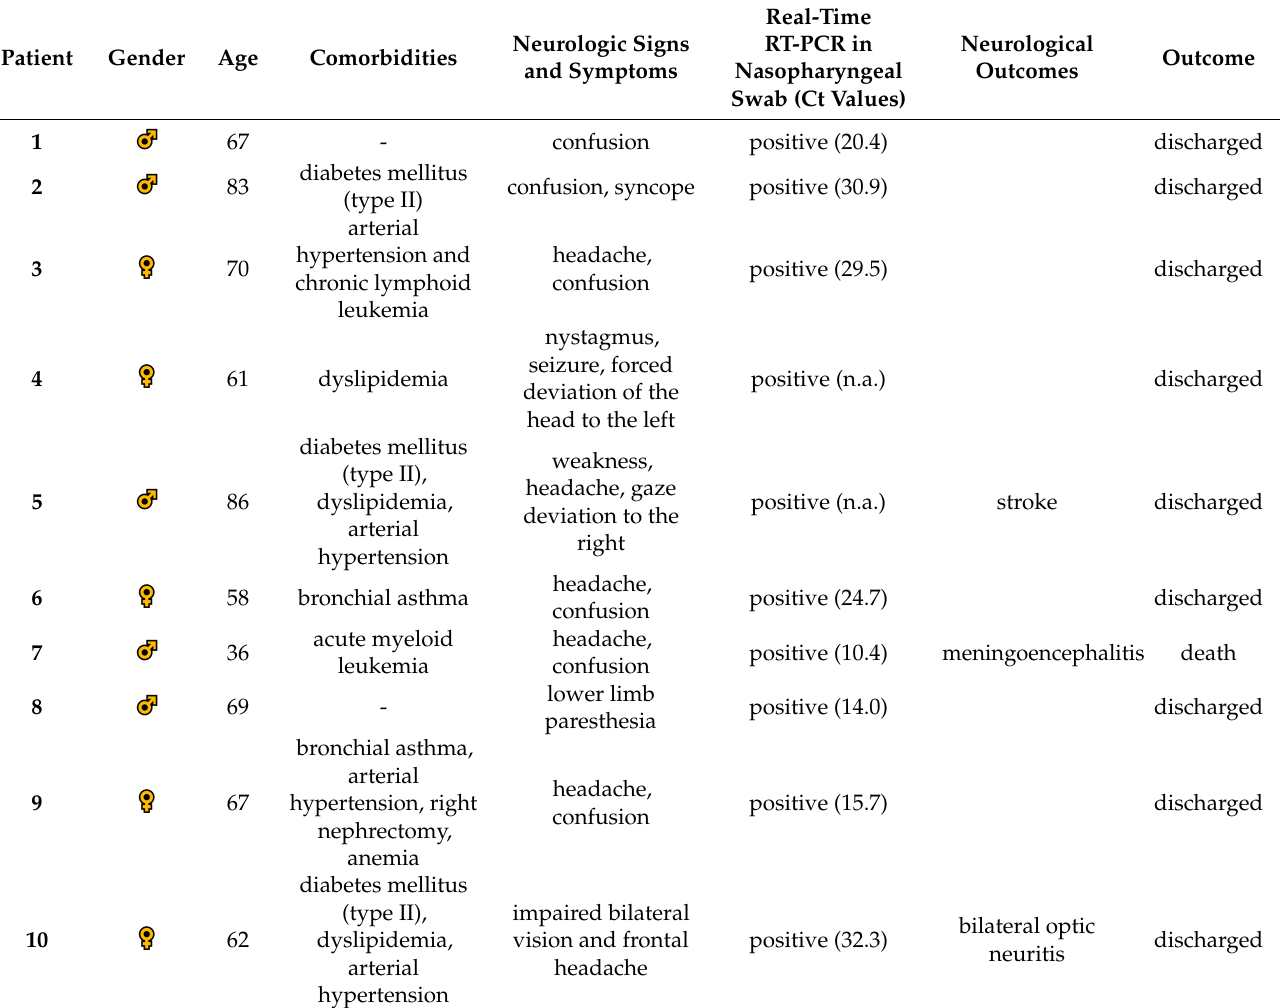
Table 2. Demographic and clinical features of neuro-COVID group.